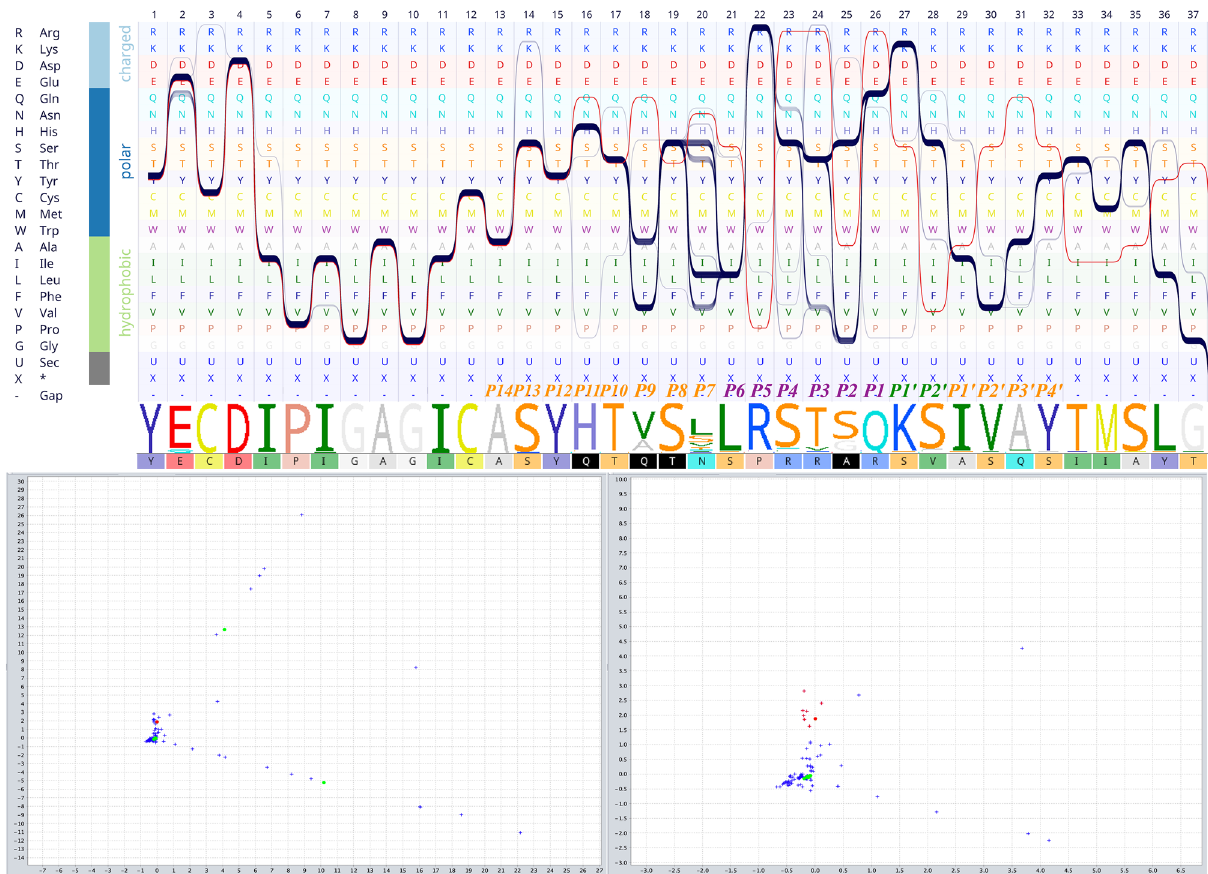
Figure 6. Bundle representation of furin cleavage site and correspondence scatter plot. The left panel shows the one-to-one comparison of sequence MSA of the furin cleavage sites of different coronaviruses. The 20 amino acids of the furin cleavage motif are depicted by different colors on the top of the sequence alignment logo (P stands for the position). The color scheme of fonts is based on reference 38 . Amino acids are sorted based on their biochemical properties. Each continuous line represents a sequence in the alignment. The red line is the sequence of the Sgp SARS-CoV-2 furin cleavage site. The lower panel shows the correspondence scatterplot and a close look at the selected correspondence sites (left and right panels, respectively). The corresponding residues are in black boxes in the sequence of Sgp SARS-CoV-2 on the left panel. X and Y axes are the first and second principal components,